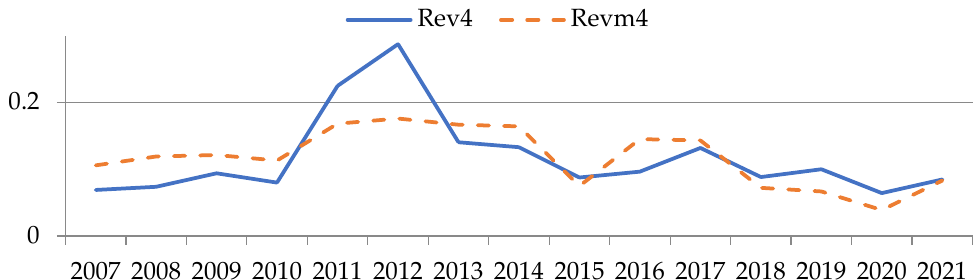
Figure 4. Comparison between real revenue and model value calculated by Formula (1) for industry No. 4 (author’s results).